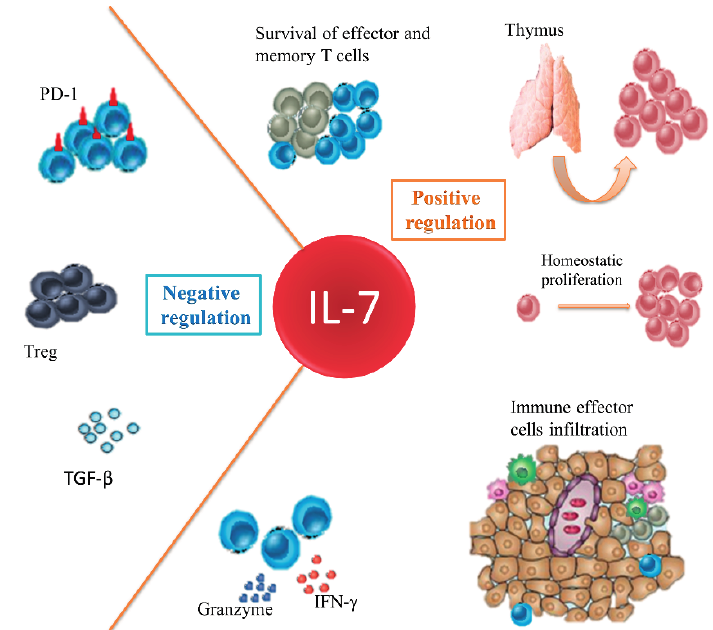
Figure 1. Effects of IL-7 in cancer immunotherapy. IL-7 can maintain the survival of CTLs and memory T cells. It promotes immune reconstitution both from the thymus-independent homeostatic expansion of peripheral T cells and